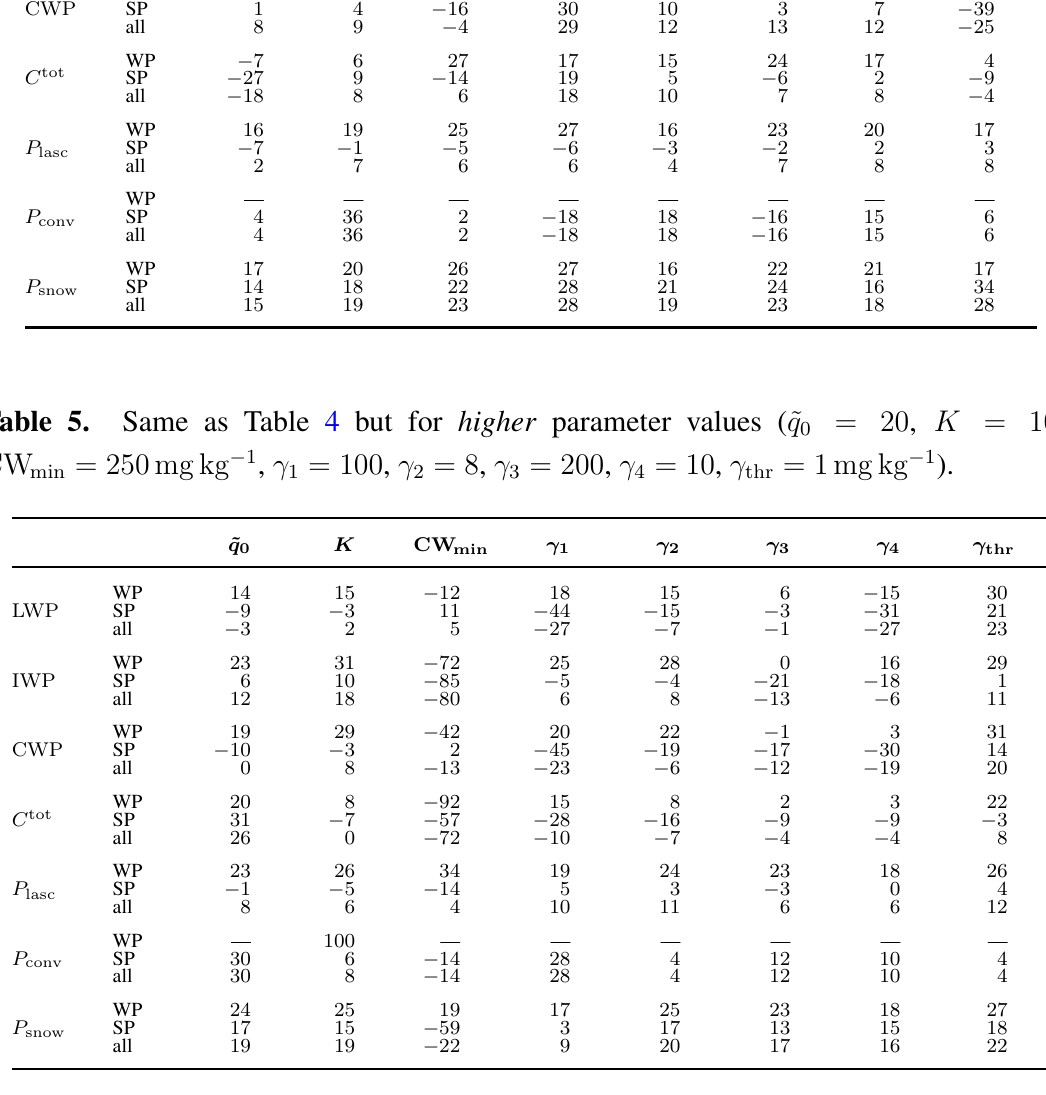
Table 4. Percental decrease/increase of several model variables due to lower parameter = 1 . 5 , K = 1 , CW values ( ˜ q 0 γ = 0 . 025 , γ = 0 . 05 mg kg − 1 ) relative to the default (Table 1) for the entire 13-month- 4 thr